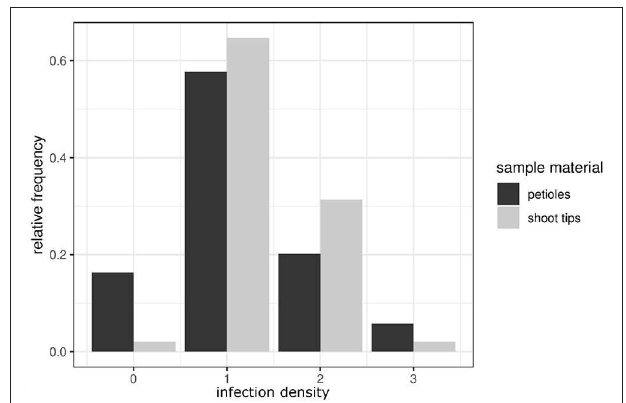
FIGURE 7 | Comparison of the infection classes observed in petioles and shoot tips. The relative frequency of infection classes in shoot tips (presented in light gray) compared to the classification frequencies in petioles (dark gray bars). The bars represent the distribution of the density of infestation in the petioles and shoot tips in susceptible cultivars. Classes range from class 0 (no infection) to class 3 (high density of a P. viticola infection).